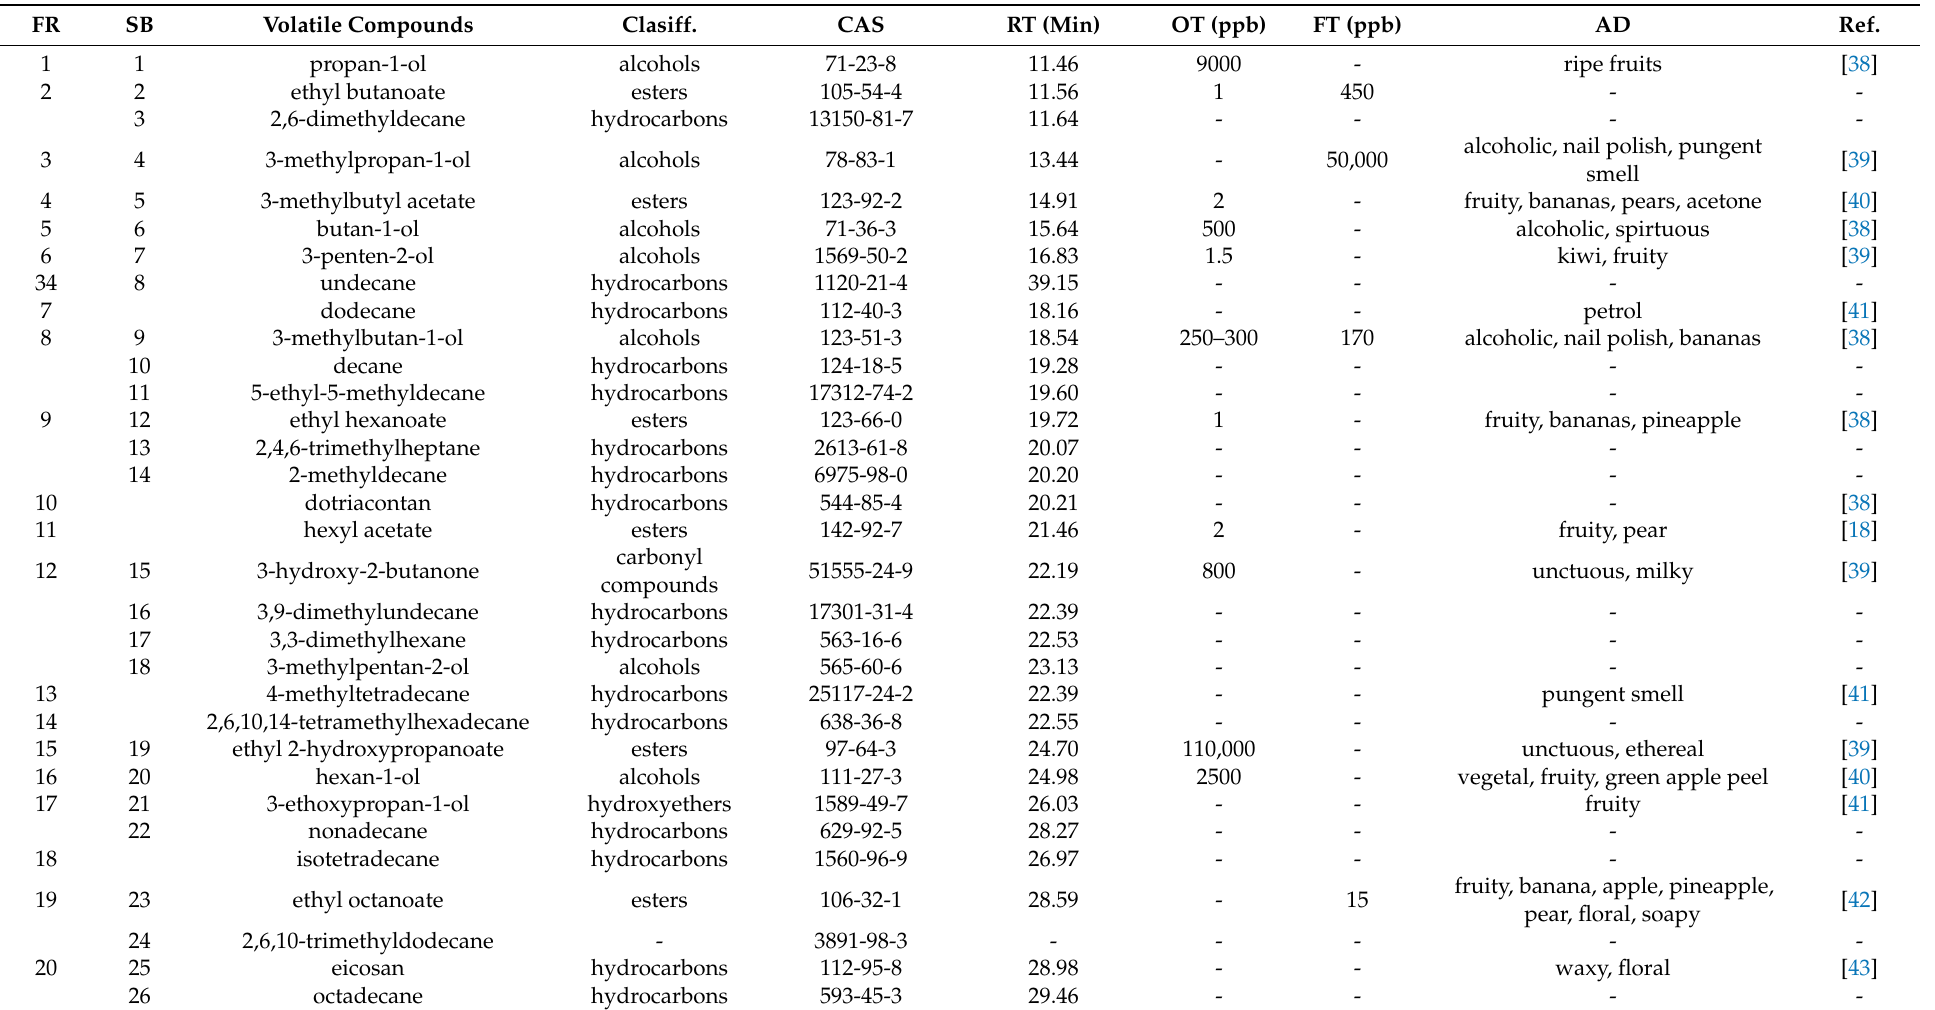
Table 1. Aroma descriptor and thresholds of the analyzed volatile